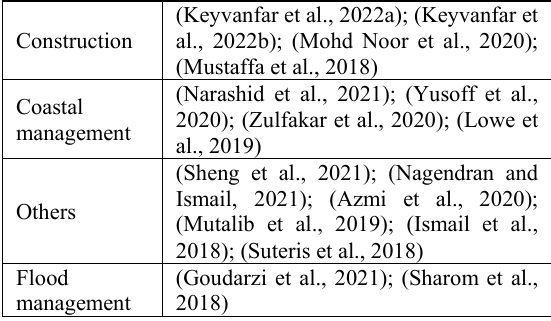
Figure 8. Application areas of drones in